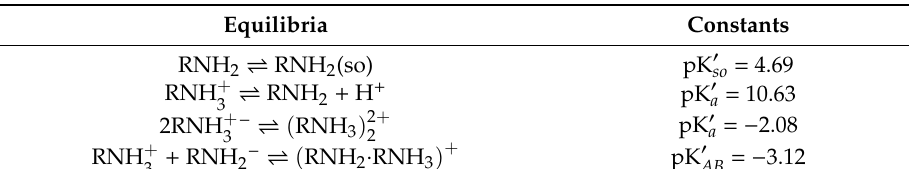
Table 3. Equilibrium constants for dodecylamine species in aqueous solution [40] (total ionic concentration = 5 × 10 − 2 mol/L).